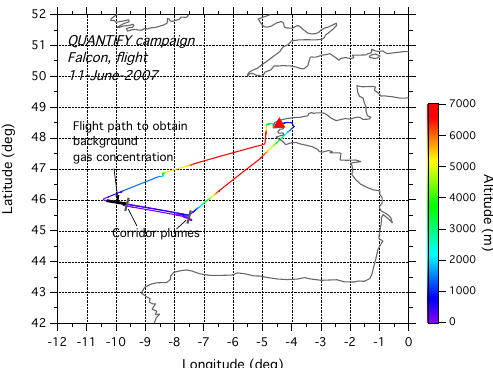
Figure 1. Map of research domain with flight path for 11 June 2007. The section of the flight path marked with “corridor plumes” marks the section of the path where the shipping corridor was sampled. Also marked is the section of the path that was used to obtain the background gas concentration (see Sect. 3.3 and Table 2 for